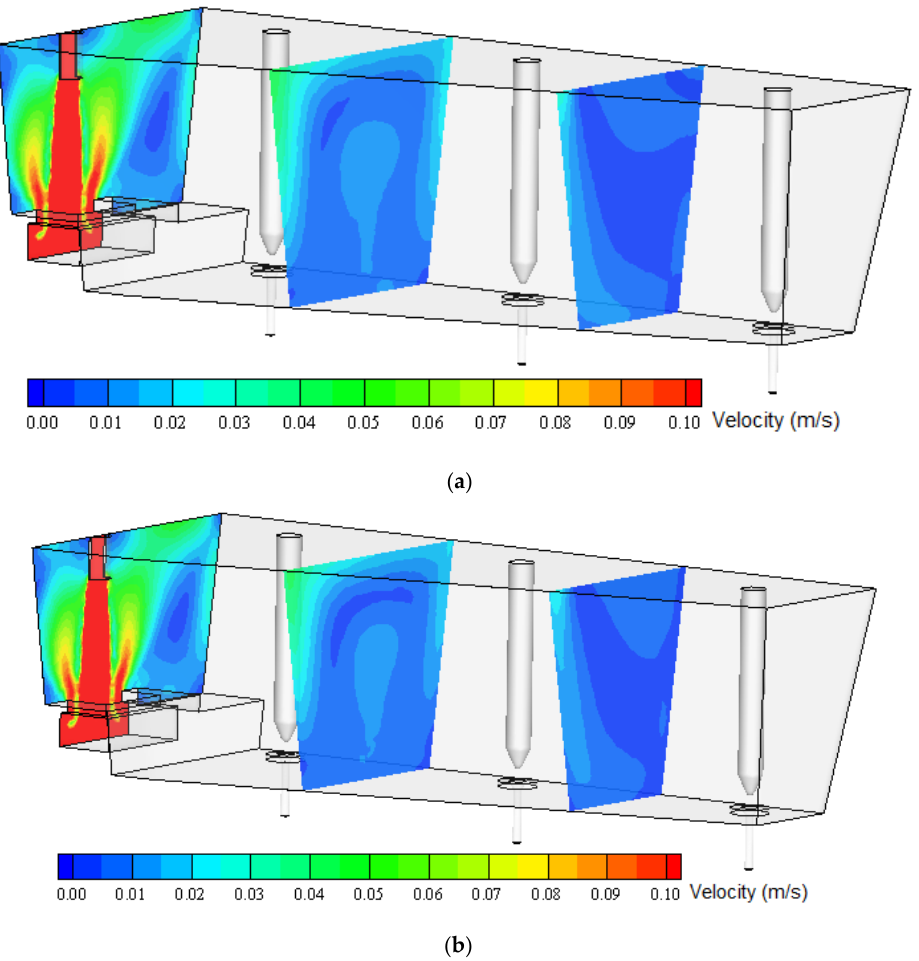
Figure 12. Numerically predicted velocity field of liquid steel on transverse tundish planes: ( a ) base viscosity, ( b ) experimentally obtained viscosity.